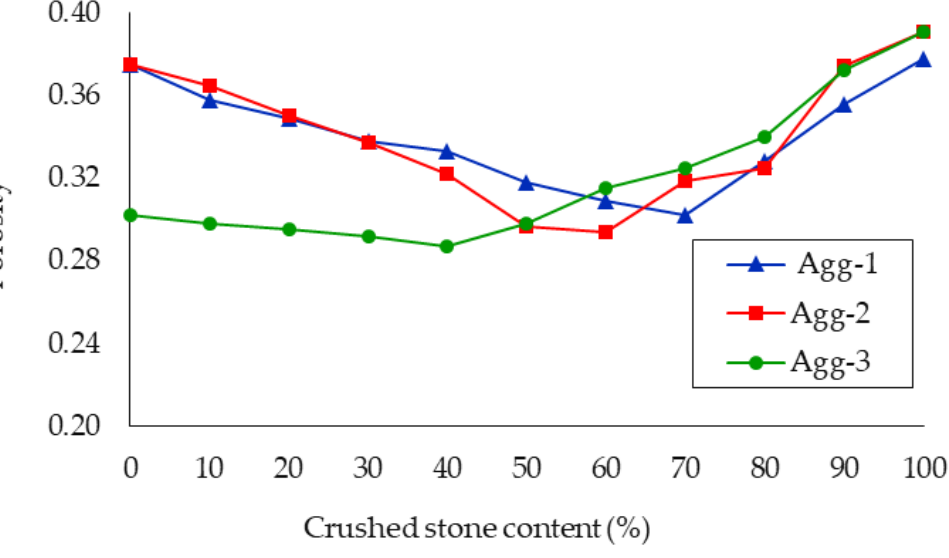
Figure 3. Porosity of three cases.